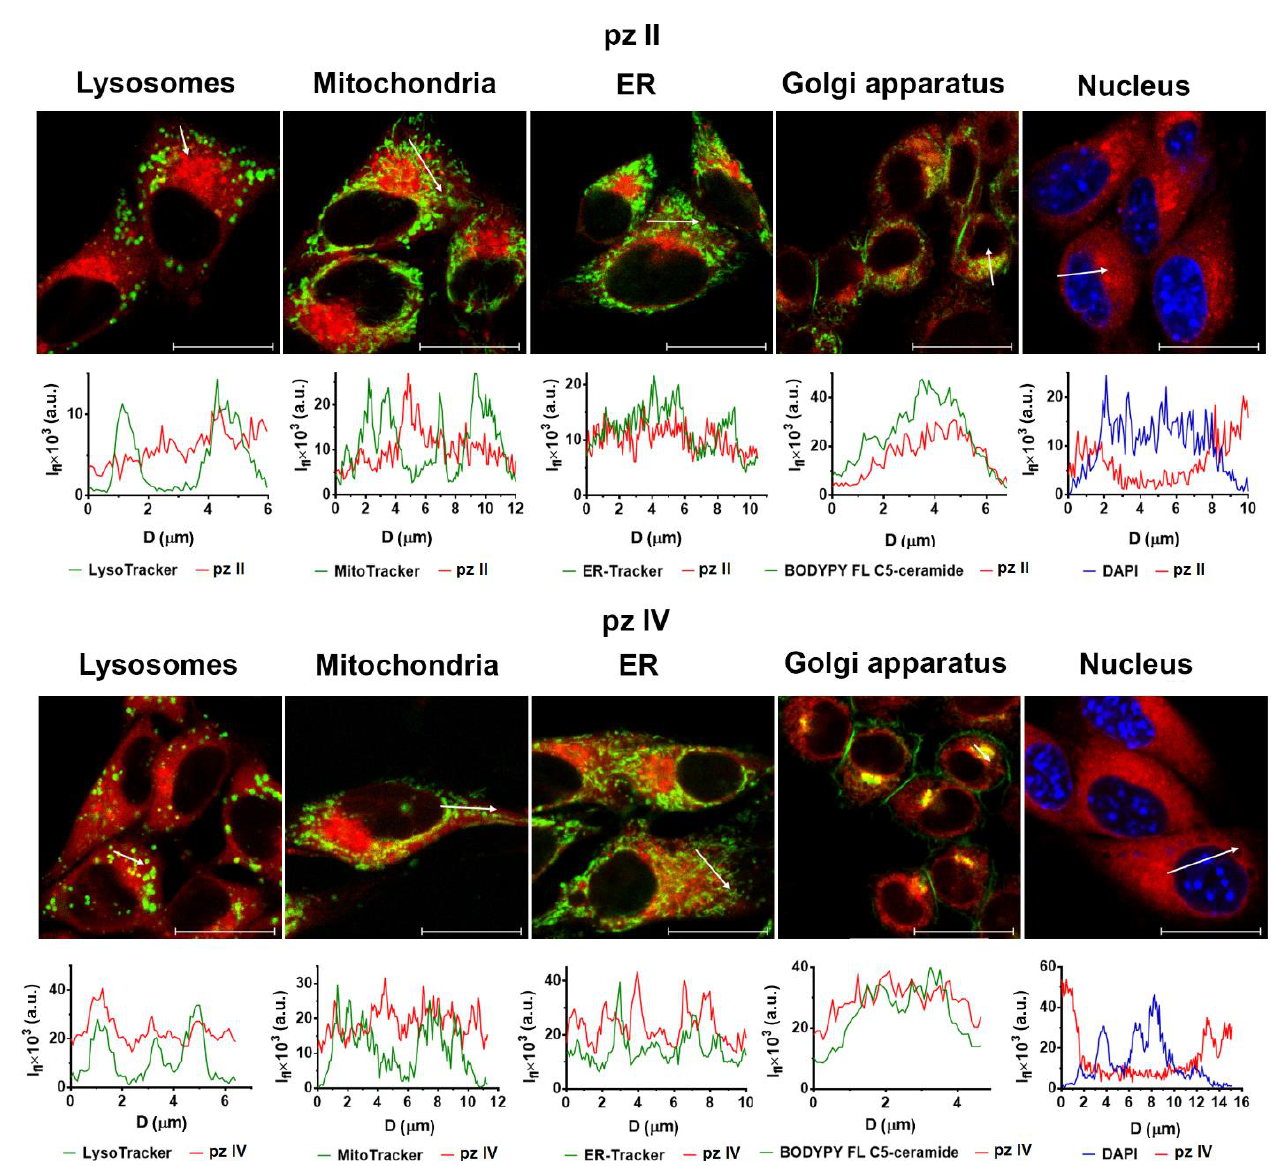
Figure 8. A subcellular distribution of pz II and pz IV in the glioma GL261 cells. Glioma cells were incubated with 10 µM pz for 4 h. The following dyes were used for staining of the organelles: LysoTracker Green for lysosomes; MitoTracker Green for mitochondria; ER-Tracker for ER; DAPI for nucleus. The plots present the profiles of the fluorescence signal (I fl ) of the pz (red line) and organelle dye (green and blue line) along the white arrow indicated in the corresponding image. Scale bar, 20 µm.